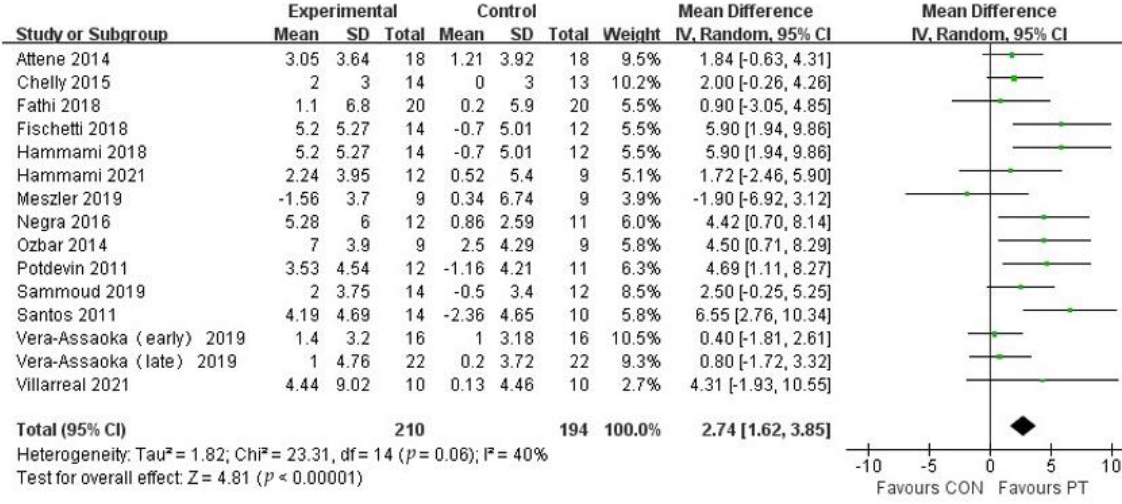
Figure 4. Forest plot of CMJ of experimental and control groups.